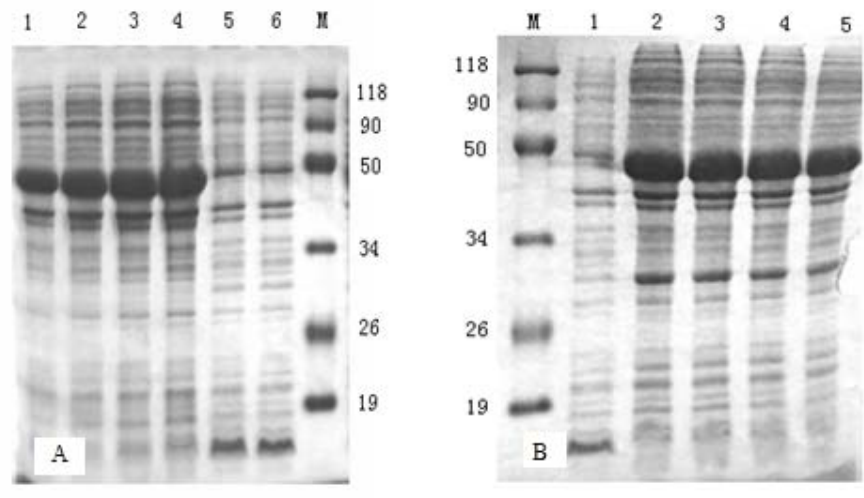
Figure 3. SDS-PAGE analysis. (A) SDS-PAGE analysis of β 6-1 product. Lane M represents the low-molecular-weight marker. Lanes 1–4 represent the products at different